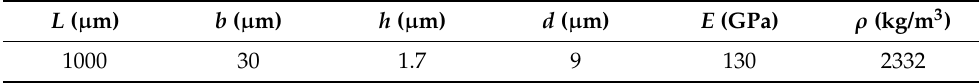
Table 3. Dimensions and material properties of the